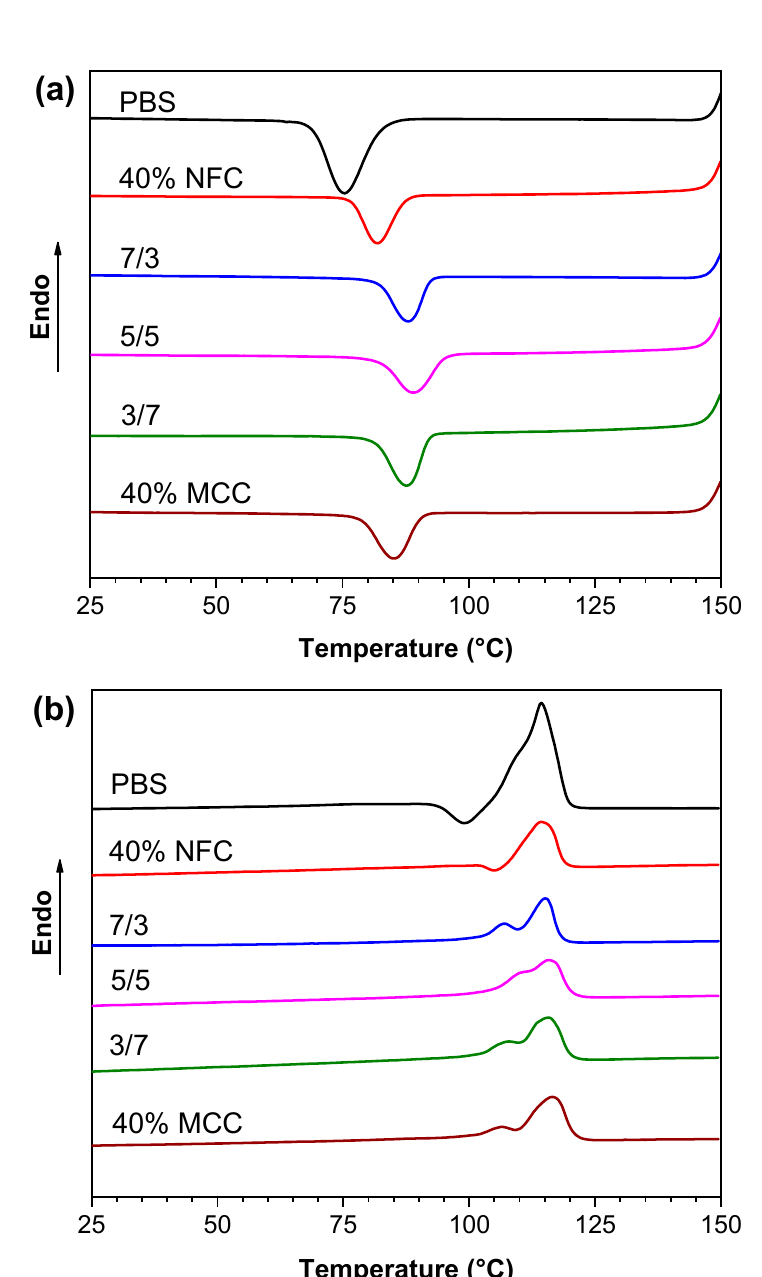
Figure 3. ( a ) Crystallization peaks of PBS and PBS/cellulose composites and ( b ) second heating melting peaks of PBS and PBS/cellulose composites under the nitrogen atmosphere.